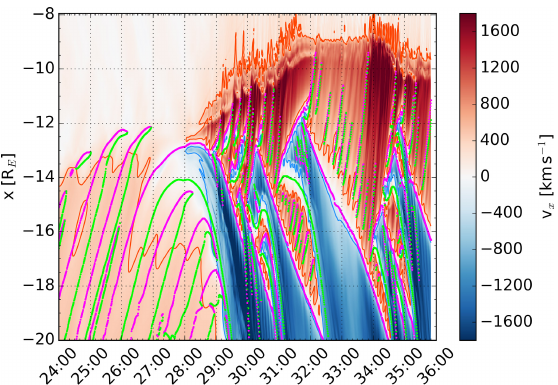
Figure 3. Earthward component of the bulk ion velocity ( V x , color) in the magnetotail plasma sheet ( y = z = 0) as a function of x and time in minutes after the beginning of the simulation (MM:SS). The ± 400kms − 1 contours are indicated with the orange and blue curves. Magenta and green dots show the locations of the X and O points, respectively.